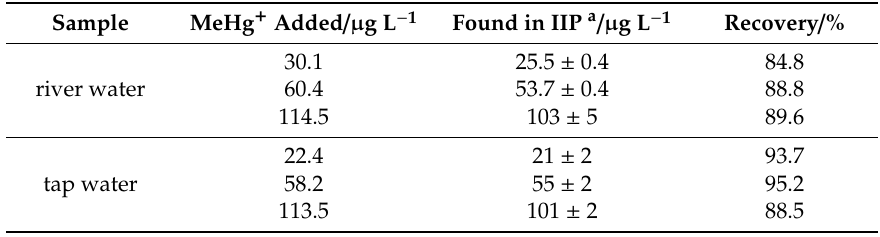
Table 5. Results obtained in recovery tests using two water samples.